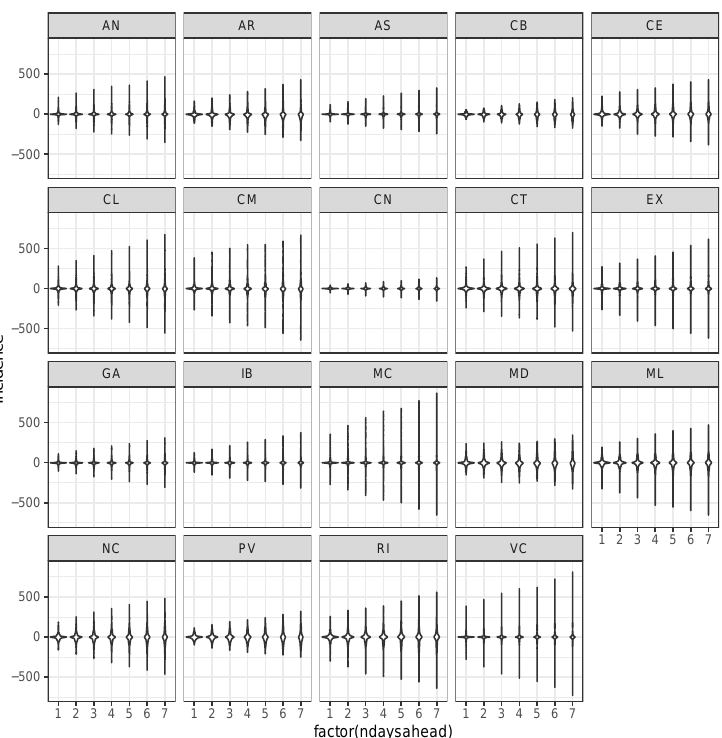
Figure A3. Violin plots of distributions of differences (cid:98) y ts − y ts conditionally to the region and the number of days ahead in the prediction using the Vector AutoRegressive model of order 1.